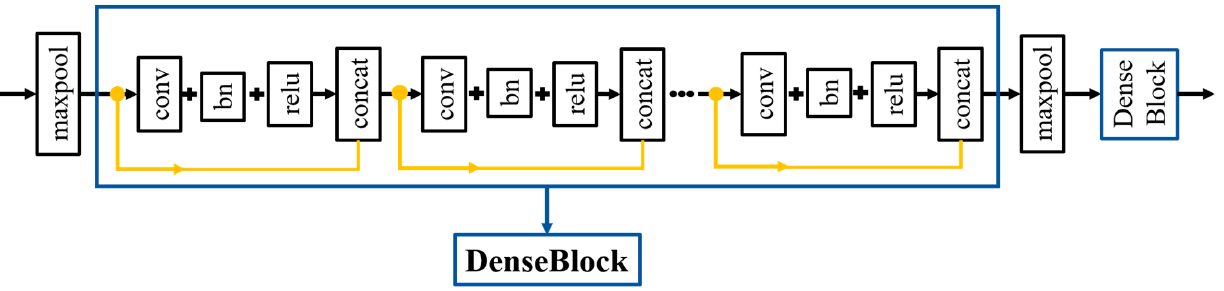
Figure 3. Structure of ResBlock module.